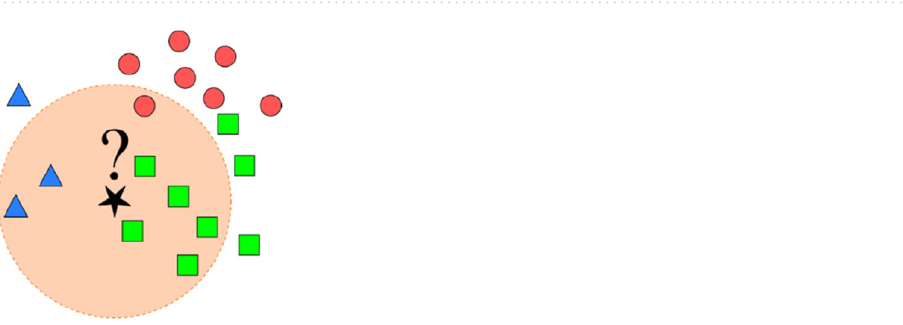
Figure 2. Typical random forest: the final class for each dataset sample is determined by majority voting on decision trees predicted classes.